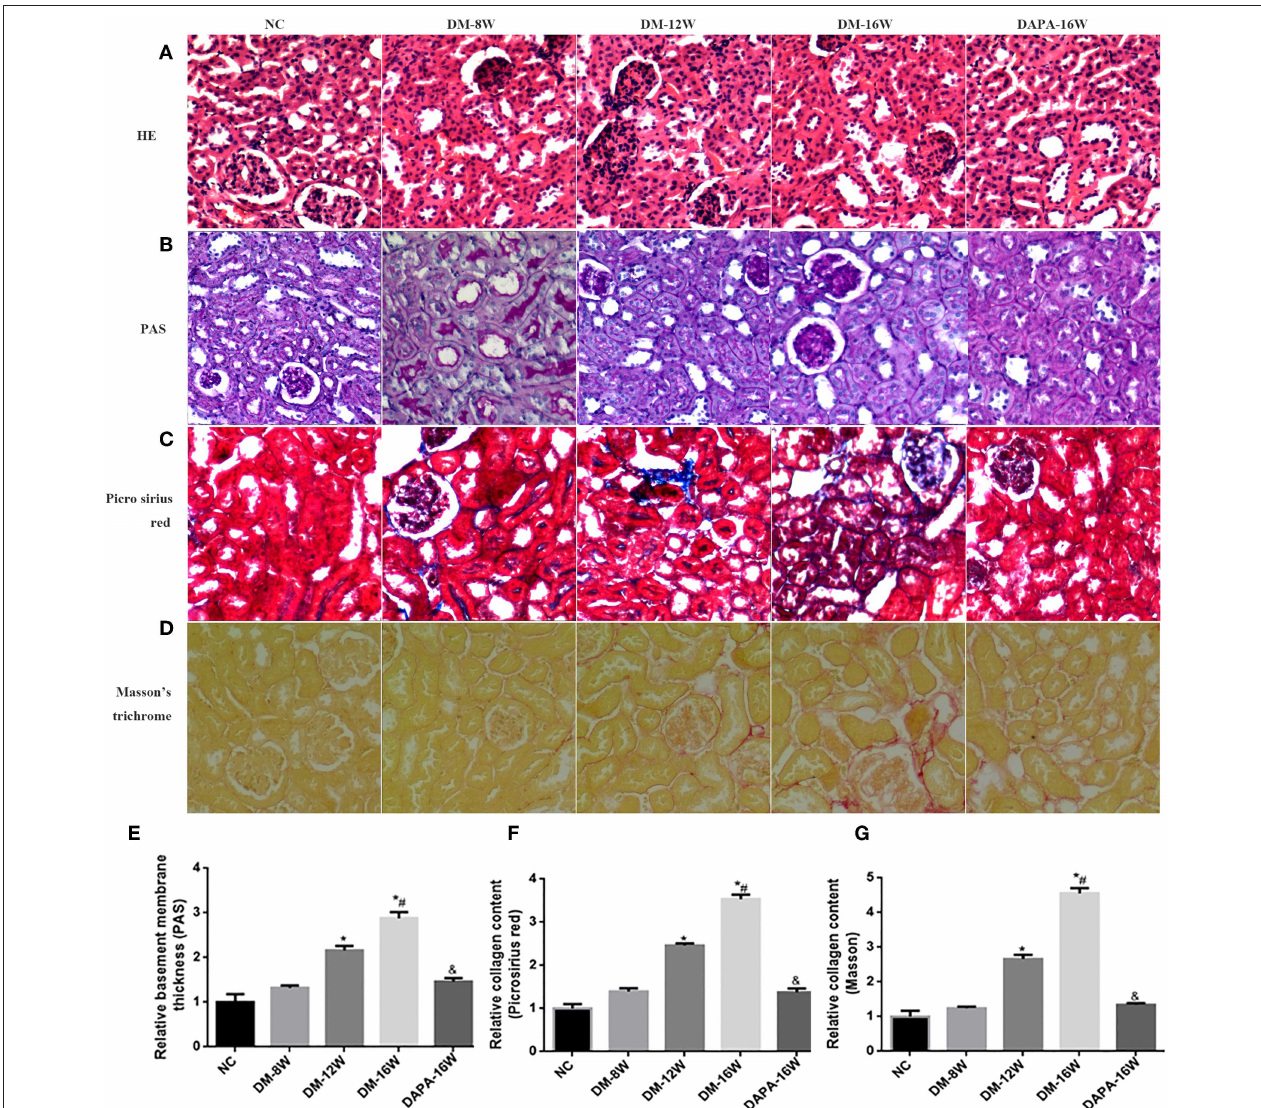
FIGURE 6 | Effect of DAPA on renal TIF. (A–D) Representative photomicrographs of H&E, PAS, Picrosirius red, and Masson’s trichrome staining. ( E–G ) Quantification of PAS, Picrosirius red and Masson’s trichrome staining. * P < 0.05 vs. NC; # P < 0.05 vs. DM-12W; & P < 0.05 vs. DM-16W. Values are mean ±